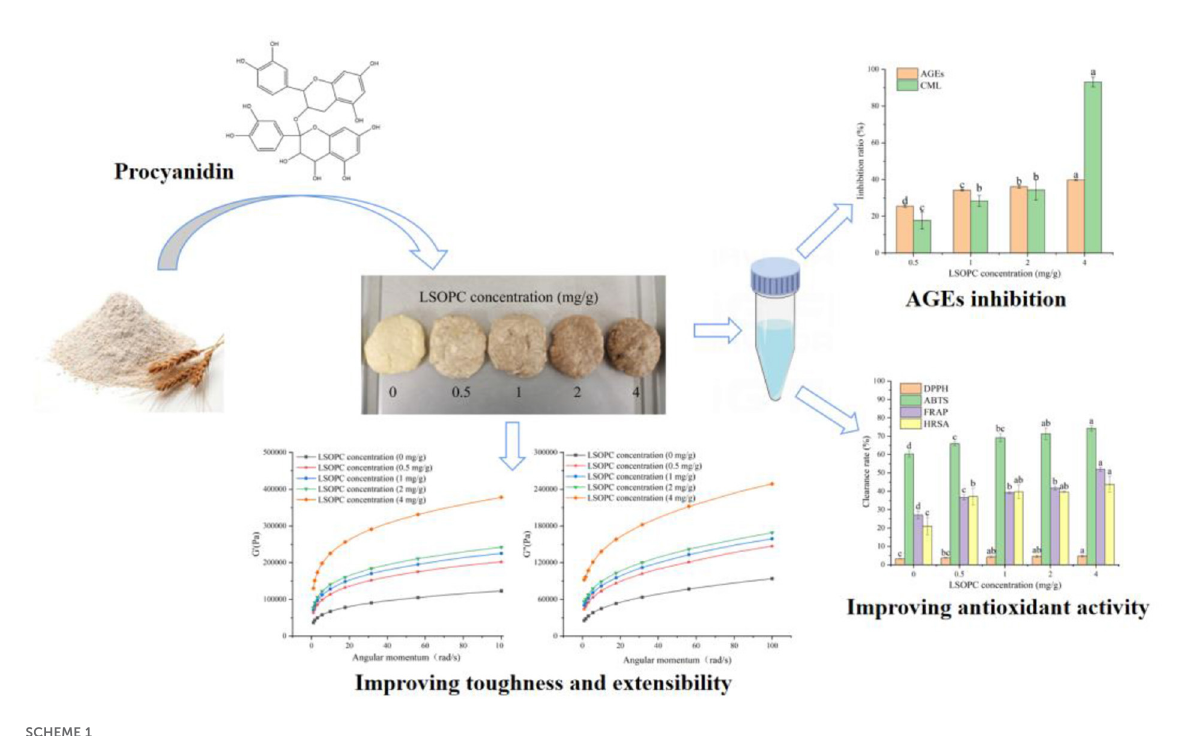
SCHEME1 Effect of LSOPC on tough